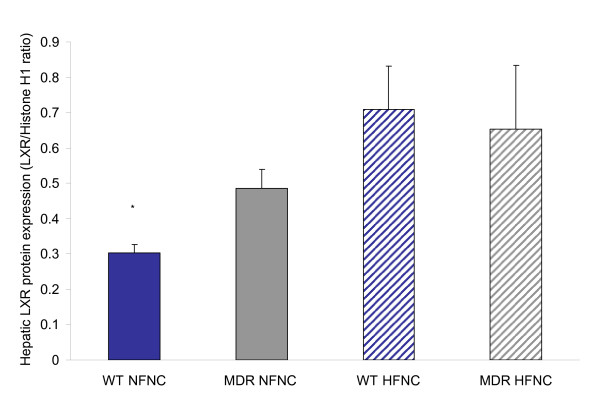
Hepatic LXRa protein expression in P-glycoprotein deficient mice (Mdr1a/-/-/1b-/-) fed normal and high fat diets. A significant increase in protein expression with both the Mdr1a/-/-/1b-/- genotype and with a high fat diet when compared to wild type animals on a normal fat diet (n = 7; p < 0.05 as noted by asterisk). Placing an Mdr1a/-/-/1b-/-animal on a high fat diet did not result in further upregulation of protein expression.